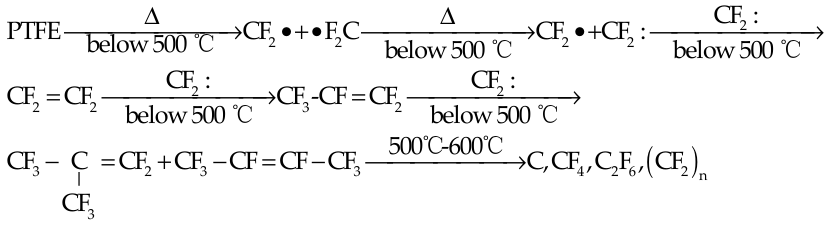
Figure 4. Structural framework diagram of pyrolysis mechanism of PTFE.